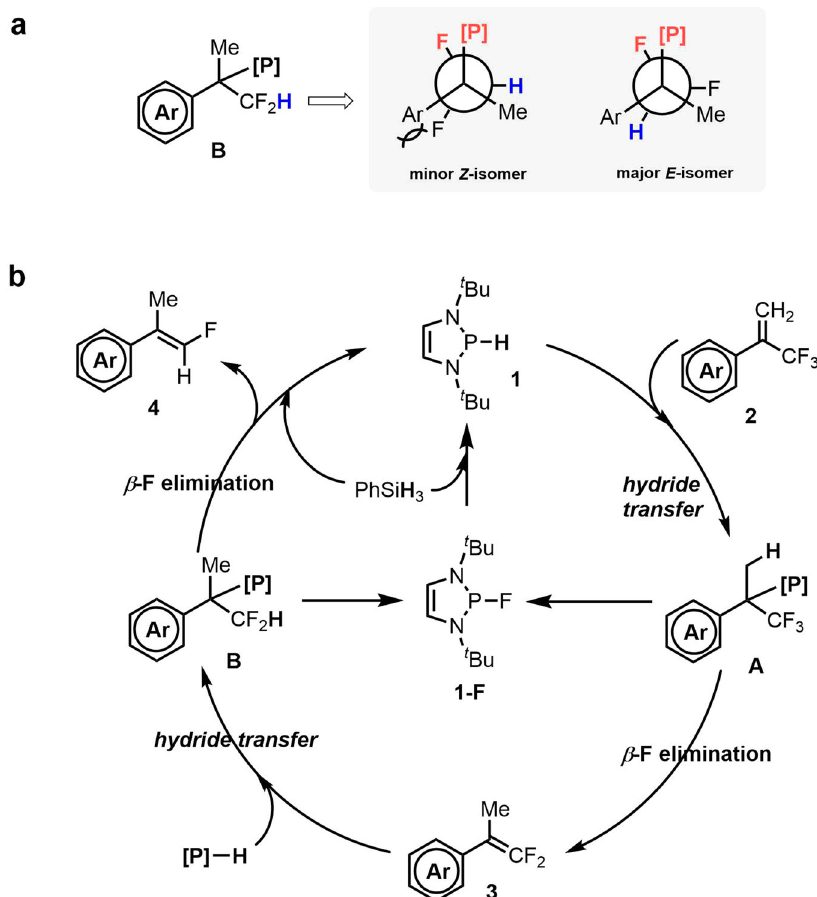
Fig. 10 The origin of the Z/E selectivity and proposed mechanism. a Newman projections of the intermediate B involved in cis - β -F elimination. b Proposed reaction